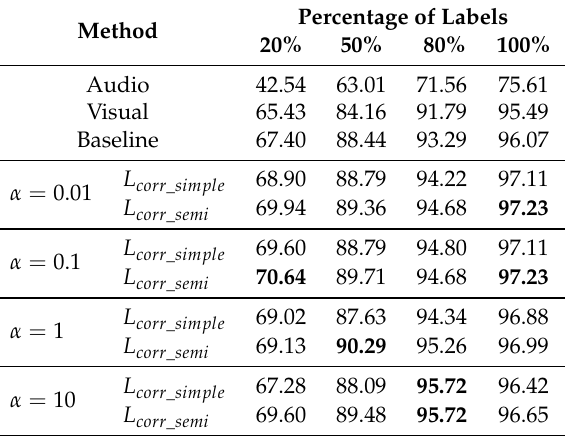
Table 7. The performance of semi-supervised audio-visual emotion recognition on the RAVDESS